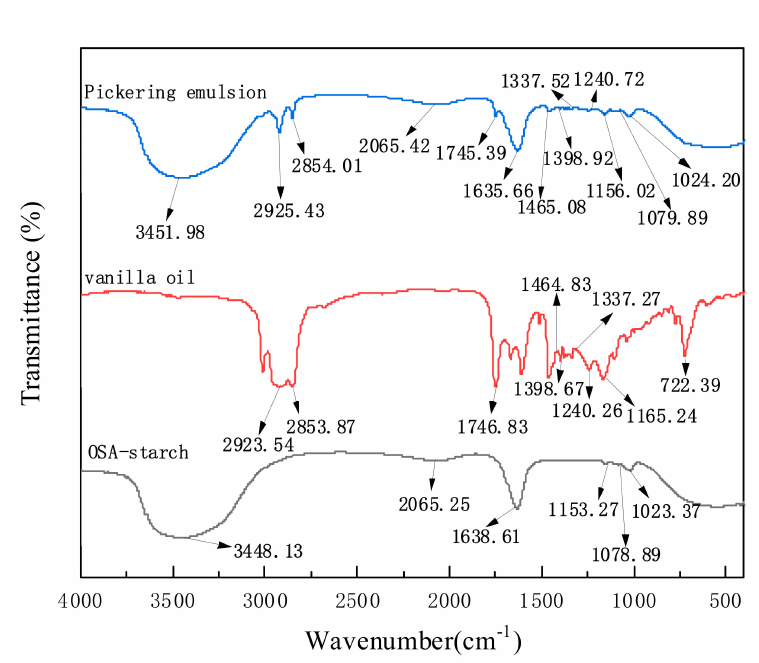
Figure 8. FT − IR spectra of OSA-starch solution, vanilla essential oil, and Pickering emulsion.